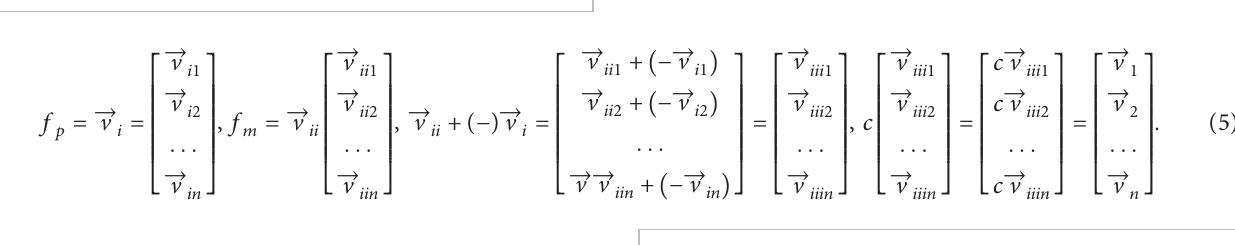
1], where h j is 1 , ... ,N ; X ( k ) � j